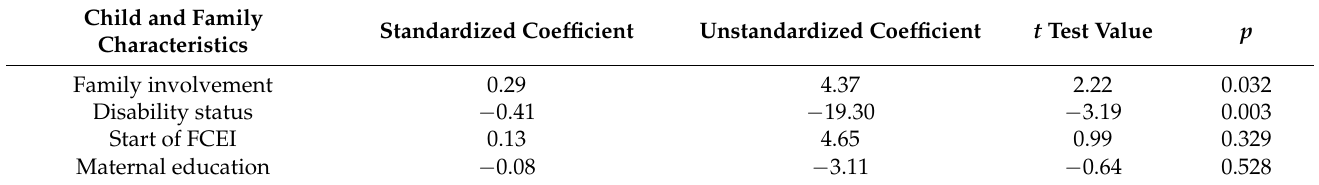
Table 5. Multiple regression predicting children’s receptive language outcomes at the age of 30 months.